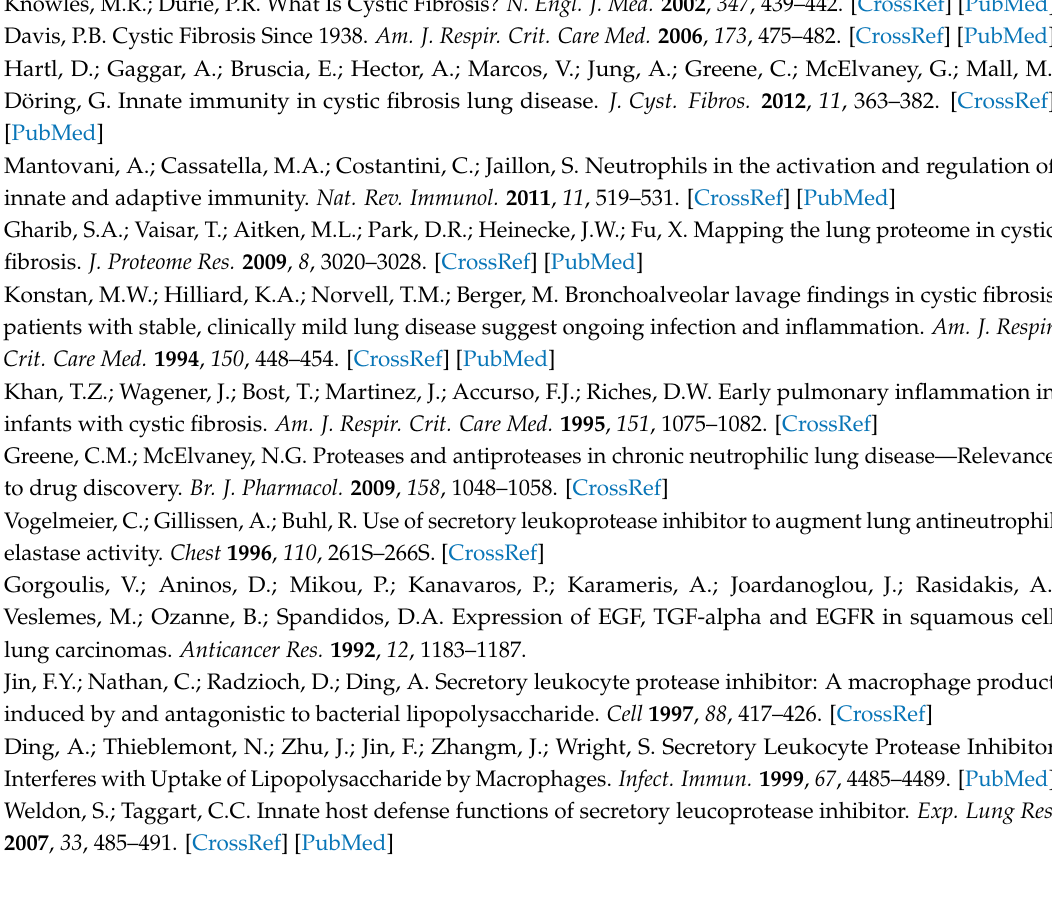
Figure S1: Representative size distribution of PM19b MP, Figure S2: Representative zeta graph of PM19b